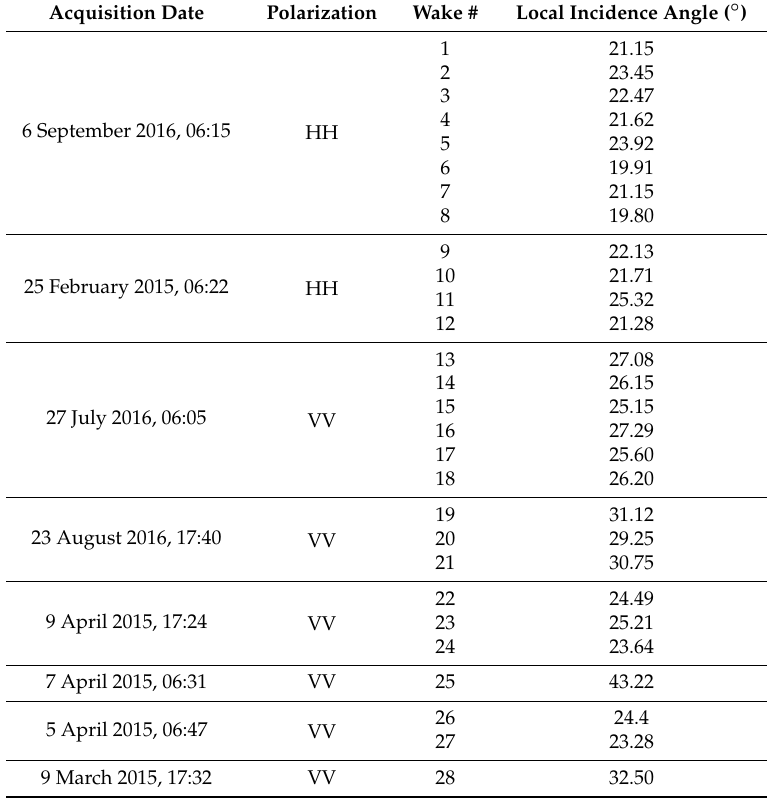
Table 2. Dataset of Sentinel-1 images. All the data are gathered by the Sentinel-1A